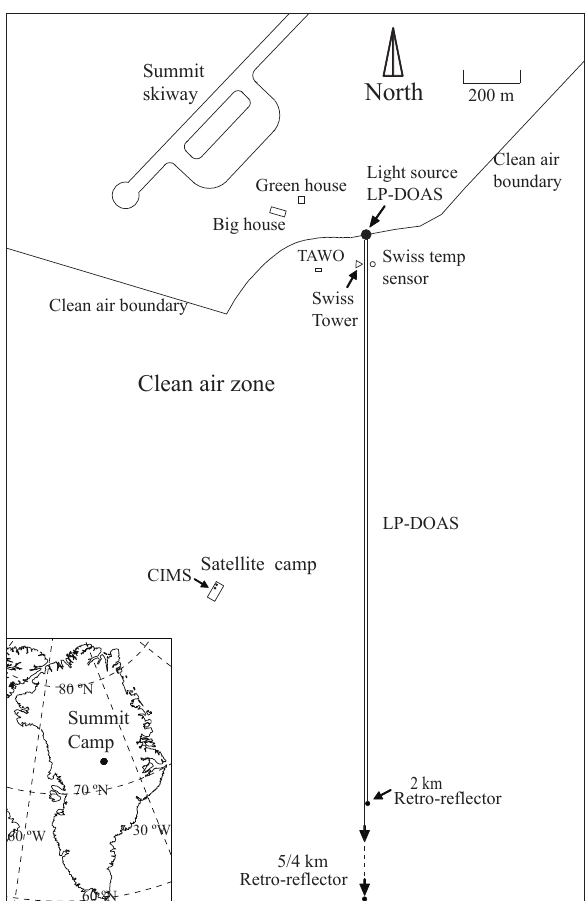
Fig. 1. The layout of the CIMS and LP-DOAS instruments in the Summit